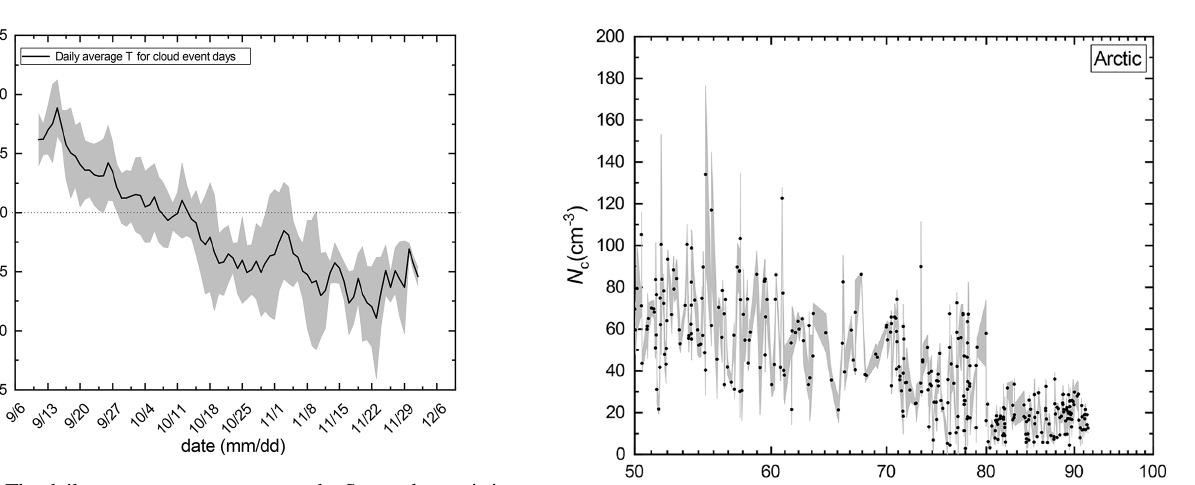
Figure 5. The daily average temperatures at the Sammaltunturi site for days with cloud events during all PaCE campaigns. The dotted line is used as a reference line for 0 ◦ C temperature. The definition of a cloud event is provided in the text. The shaded area represents the corresponding standard deviations.